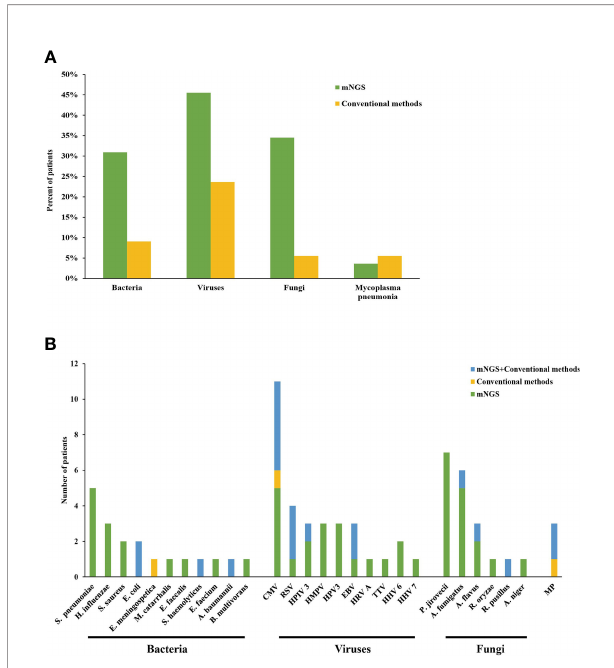
FIGURE 1 | (A, B) Distribution of pathogens detected by mNGS and conventional methods. S. pneumoniae, Streptococcus pneumoniae; H. in fl uenzae, Haemophilus in fl uenzae; S. aureus, Staphylococcus aureus; E. coli, Escherichia coli; E. meningospetica, Elizabethkingia meningospetica; M. catarrhalis, Moraxella catarrhalis; E. faecalis, Enterococcus faecalis; S. haemolyticus, Staphylococcus haemolyticus; E. faecium, Enterococcus faecium; A. baumannii, Acinetobacter baumannii; B. multivorans, Burkholderia multivorans; CMV, cytomegalovirus; RSV, Respiratory syncytial virus; HPIV 3, Human